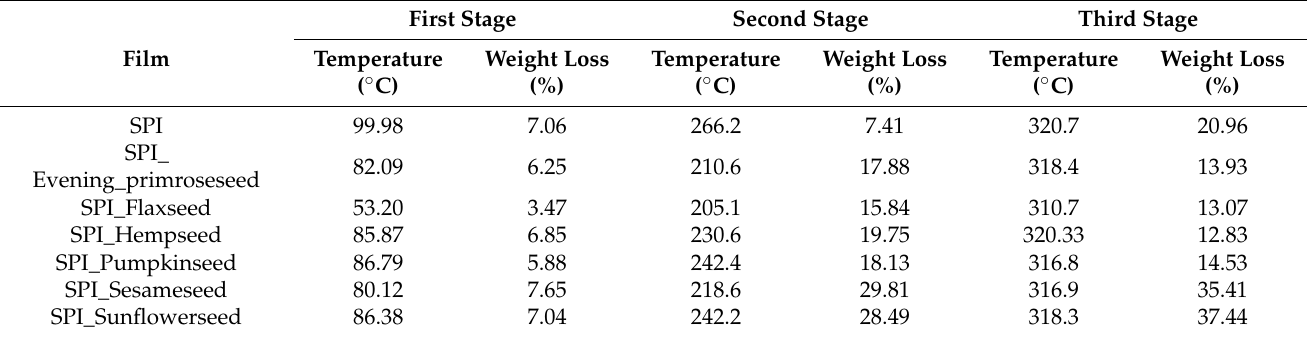
Table 5. Temperature and weight loss related to stages of TG/dTG curves of soy protein isolate–oilseed flour